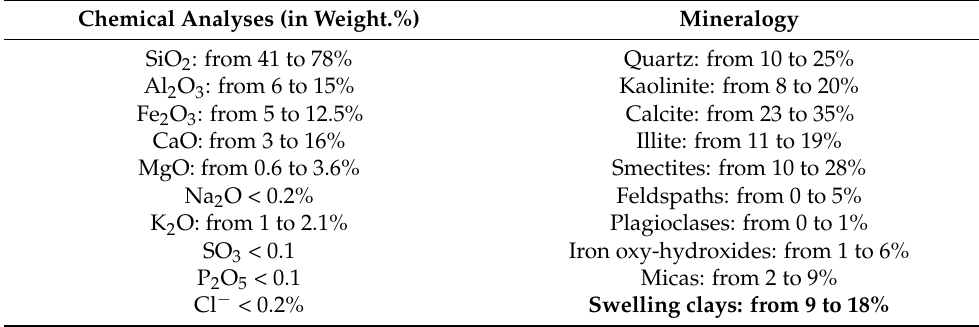
Table 12. Chemical and Mineralogical Properties of Different GWM Specimens. Chemical Analyses (in